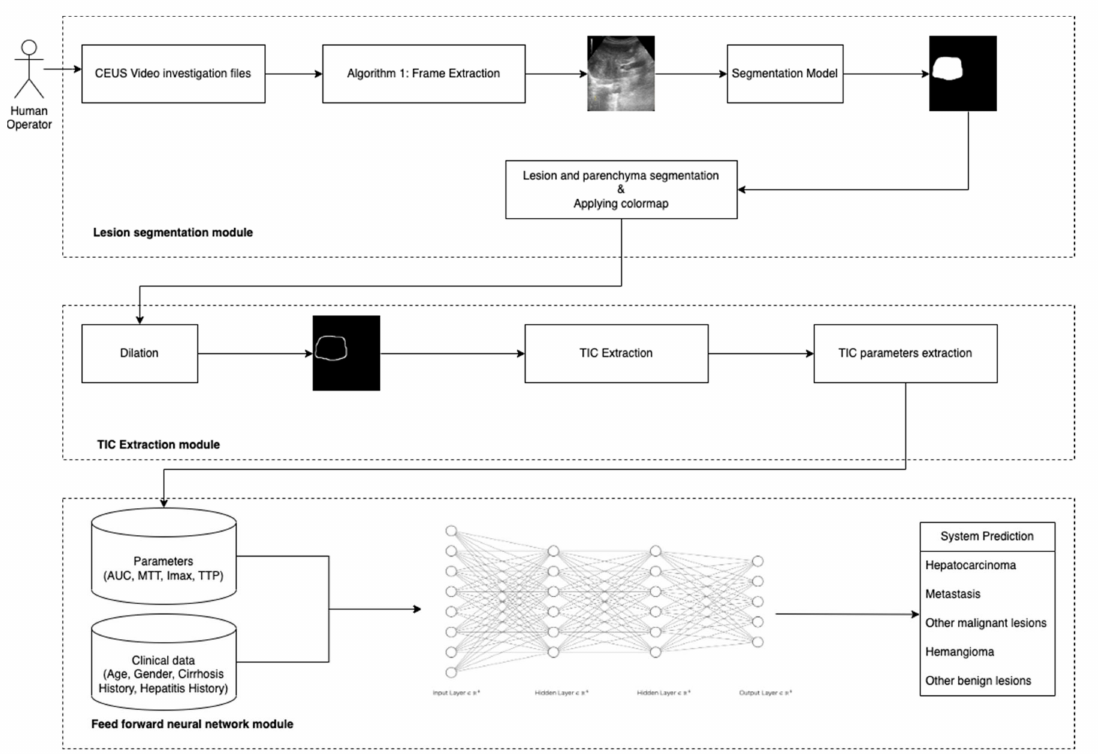
Figure 1. Architecture of the proposed